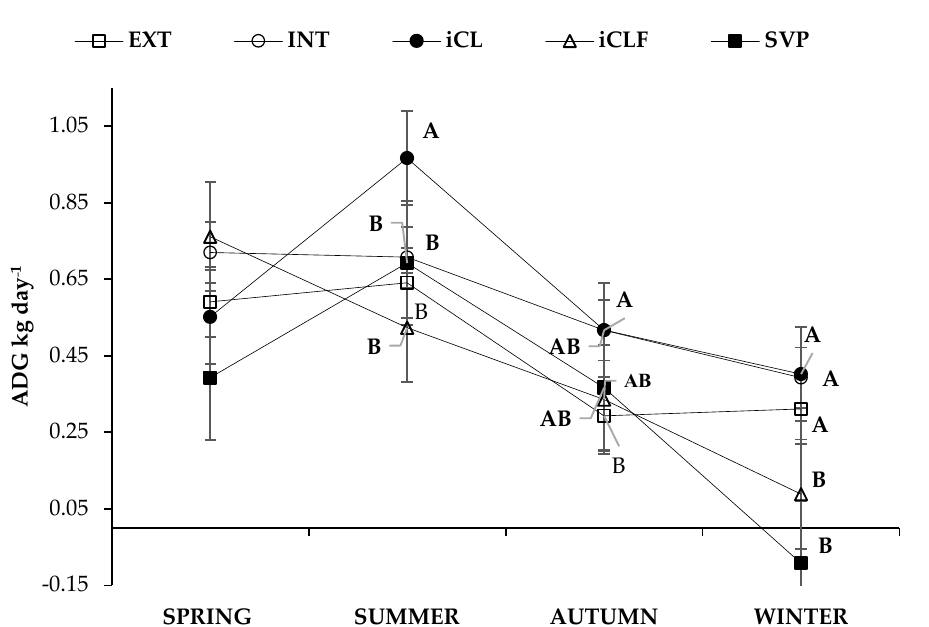
Figure A7. Feed conversion (in %) during seasons from different livestock production systems (means of two years). Different letters in the same season differ from each other ( p < 0.05) according to the Tukey test. EXT: extensive; INT: intensive; iCL: integrated crop–livestock; iCLF: integrated crop–livestock–forest; iLF: integrated livestock–forest.